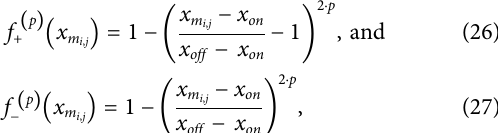
FIGURE8| CircuitimplementationoftheM-CNNcell C ( i , j ) ( i ∈ { 1 , ... , M } , j ∈ { 1 , ... , N } ).Inthisstudythecellcircuitparametersareassumedtobeinvariantacross the M × N bio-inspired memristive array. As a result, the following assumptions are made: C x to the capacitor current i